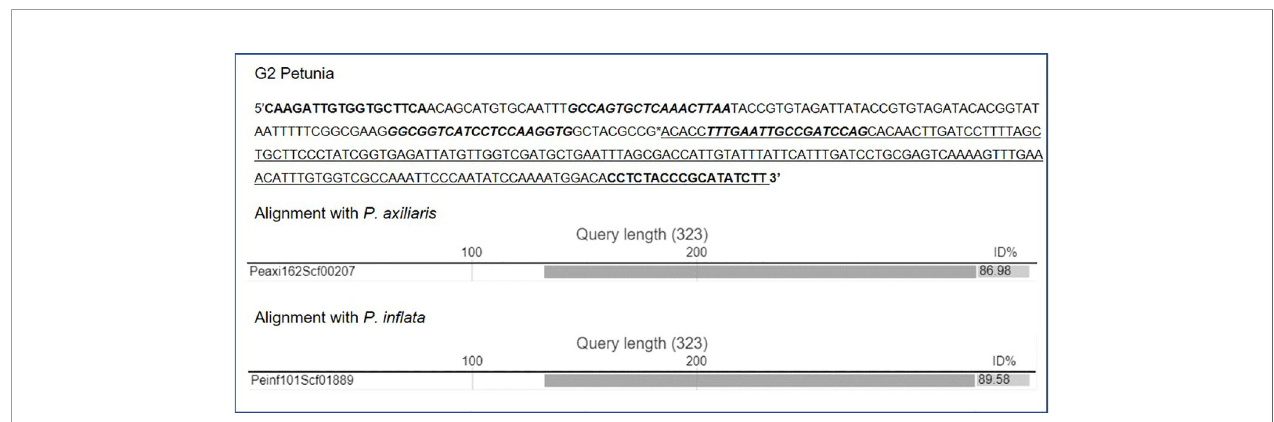
FIGURE 5 | Sequence data of the junction region present in G2 petunia as determined by MinION sequencing and con fi rmed by Sanger sequencing (sequencing primers in bold letters). Underlined are sequences with identity to Petunia ssp. sequences (Solgenomics database; alignments shown below sequence). Location of G2 primers and probe are bold italic.